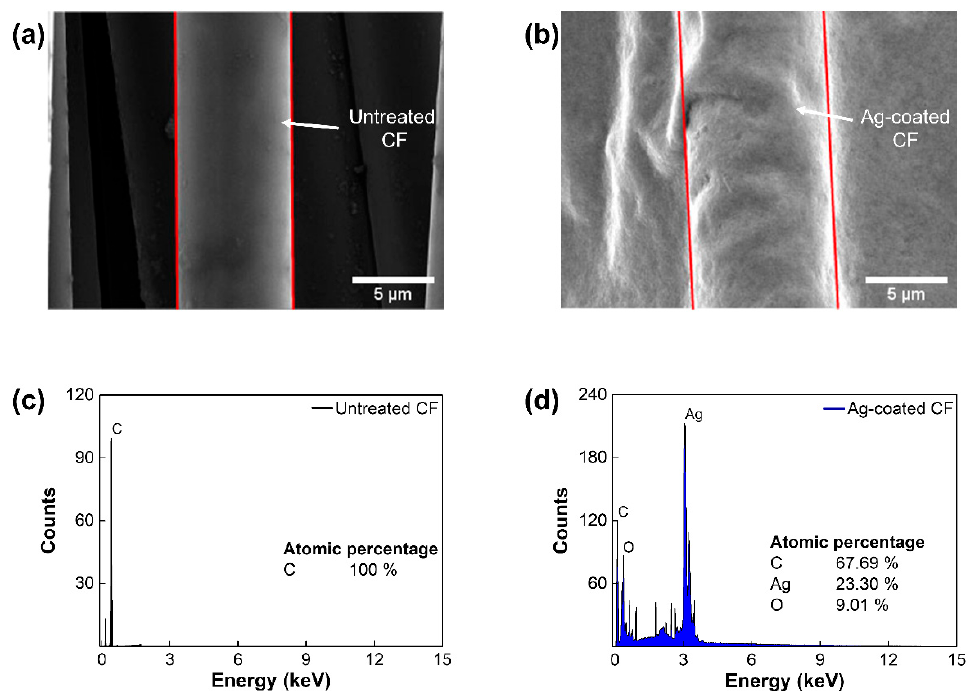
Figure 2. Elemental composition analysis of the Ag/CF film: SEM images of ( a ) untreated CF and